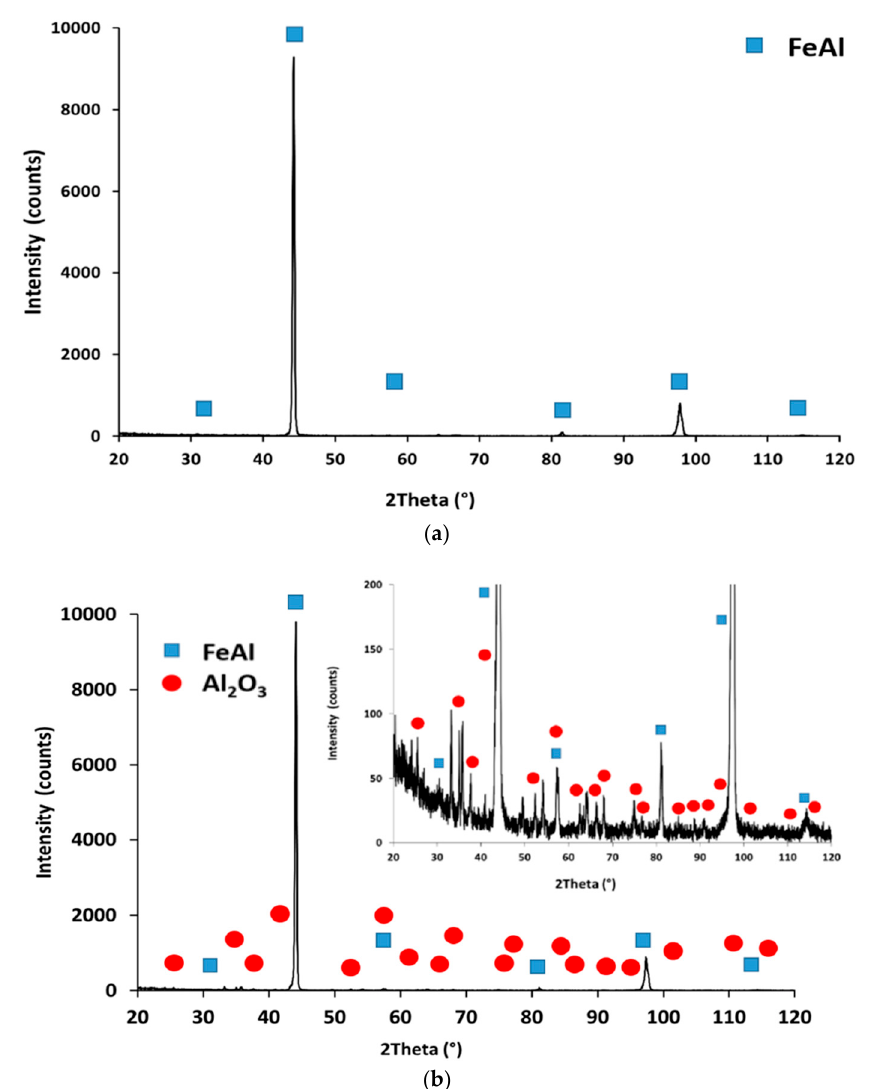
Figure 15. XRD pattern of slurry-aluminised HT347HFG steel exposed to steam at 700 °C for 3000 h under: ( a ) atmospheric pressure and ( b ) 25 MPa.